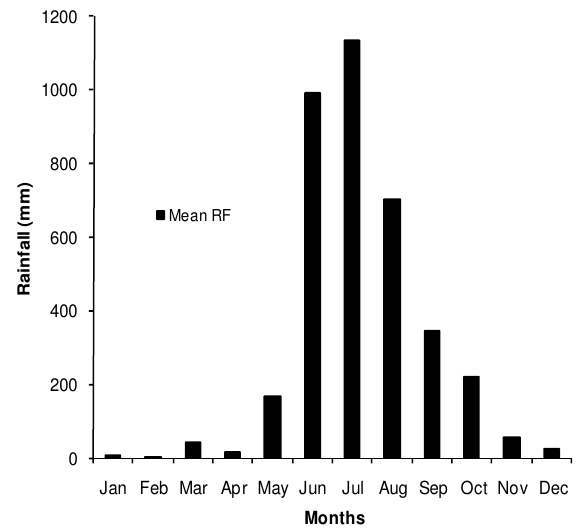
Fig. 1. Rainfall pattern in the study area (Kumta). Data from District met office, Karwar, for the period of